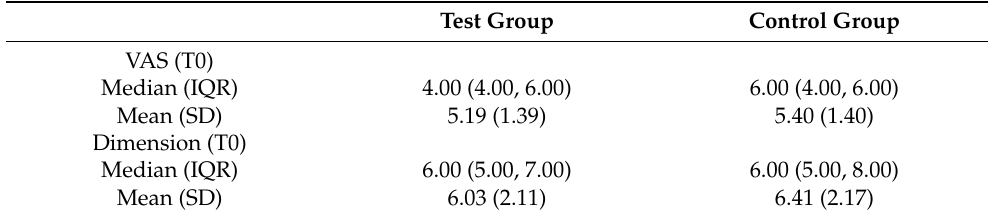
Table 2. VAS and dimension of the lesion at baseline (T0).